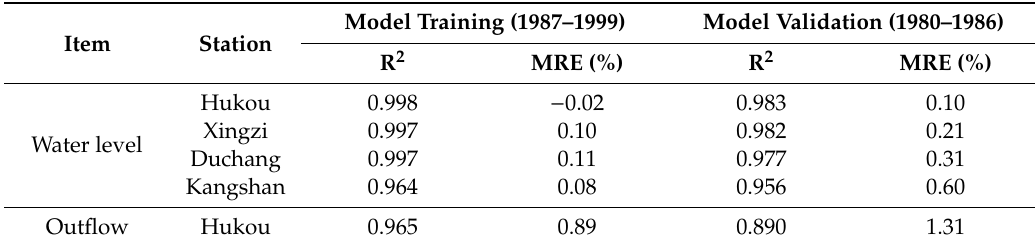
Table 1. Performance of BPNN models during the training and validation